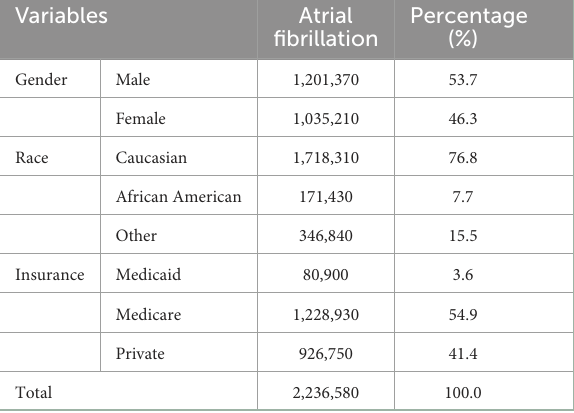
TABLE 1 Demographic distributions of all patients with atrial fibrillation. Variables